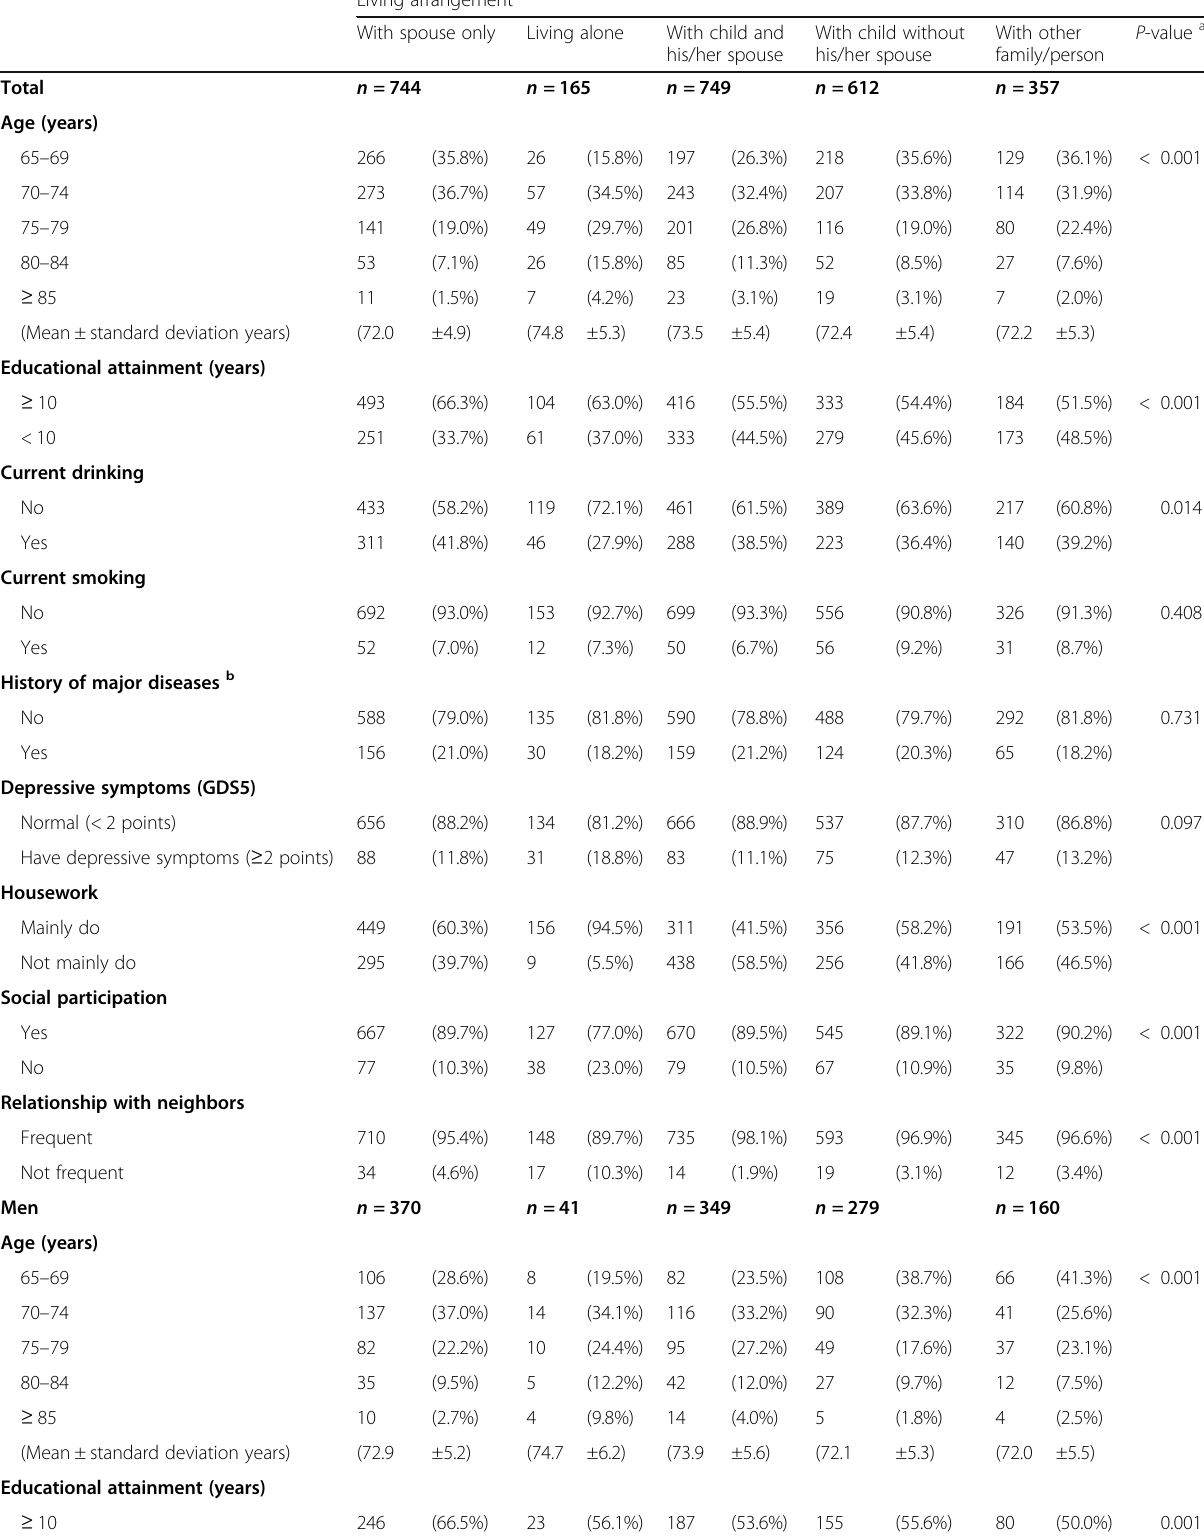
Table 1 Characteristics of the study population at baseline